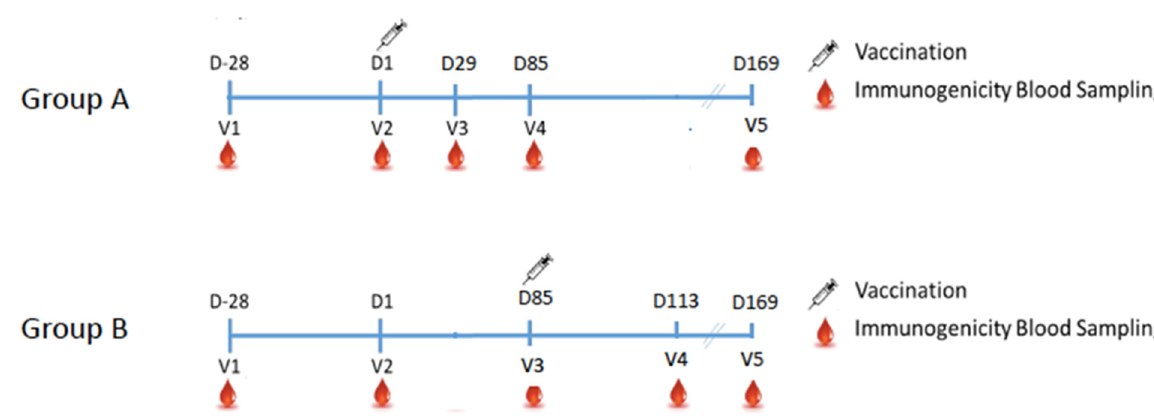
Figure 2. Study timeline and key time